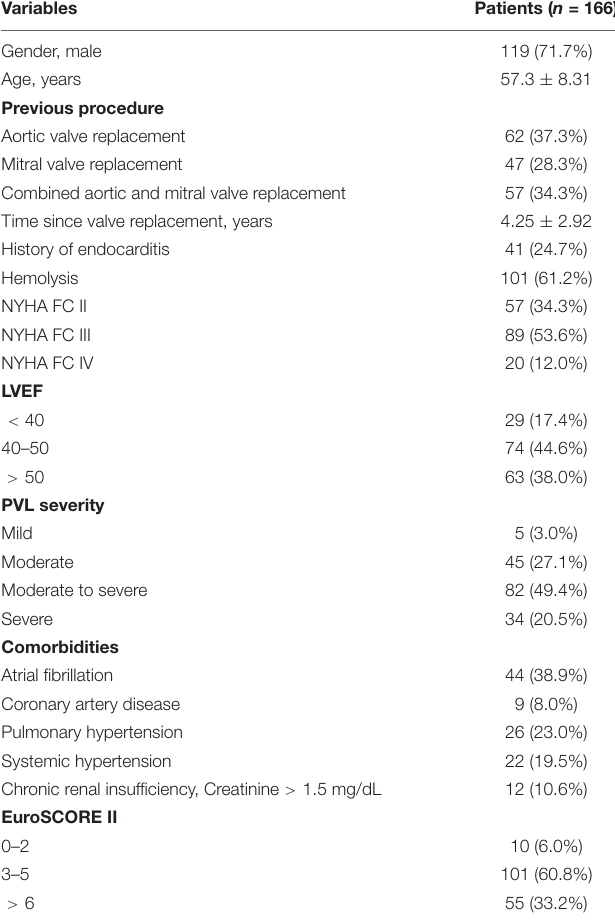
TABLE 1 | Preoperative clinical